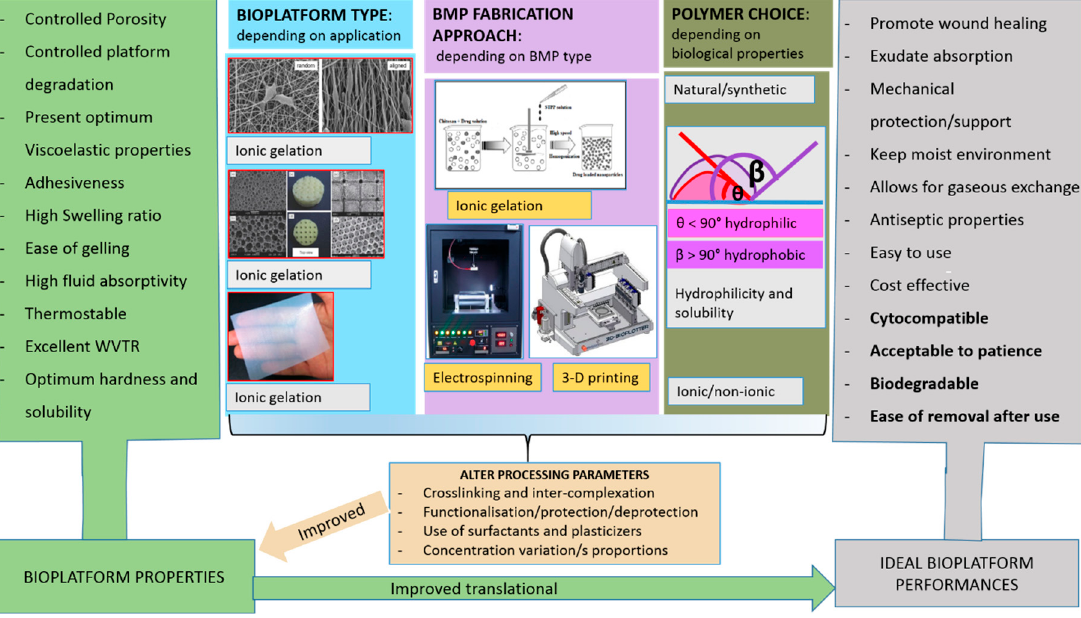
Figure 1. Schematic representation of steps required to design a suitable biomedical platform that meets the ideal requirements for an effective wound dressing. The ideal performances highlighted in bold are amongst the in vitro and in vivo drawbacks of fabricated biomedical platforms (BMPs).